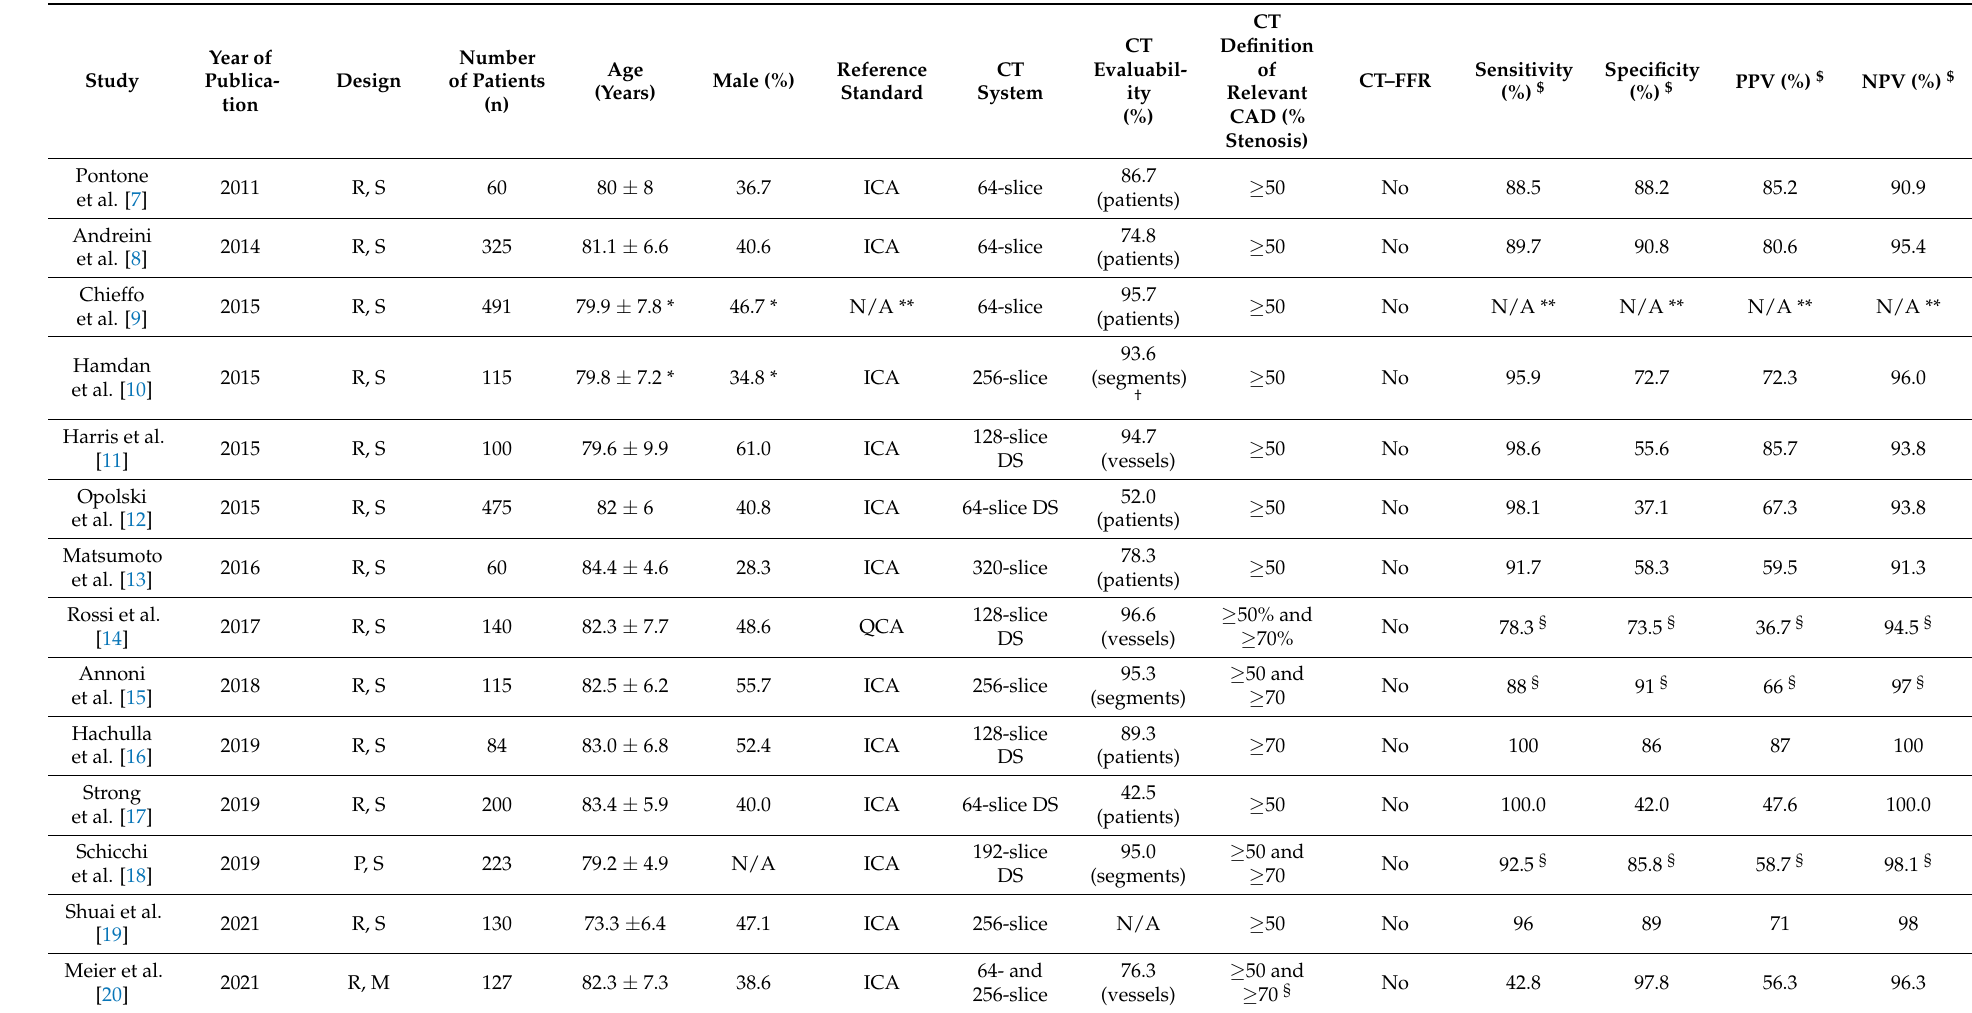
Table 1. Relevant studies focusing on the diagnostic performance of preprocedural CTA before TAVI for the detection of relevant